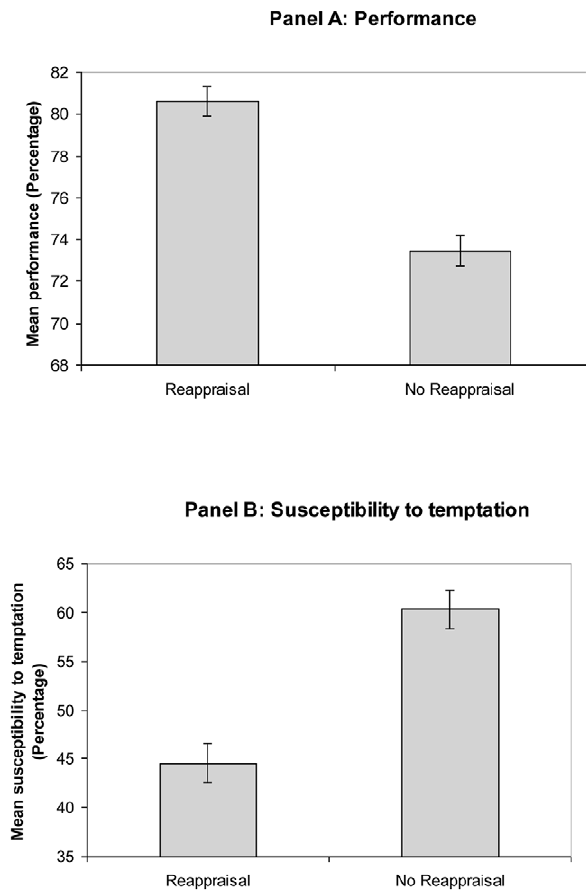
Figure 2. Mean and standard errors of the scores on performance (Panel A) and susceptibility to temptation (Panel B) by group (Study 2).